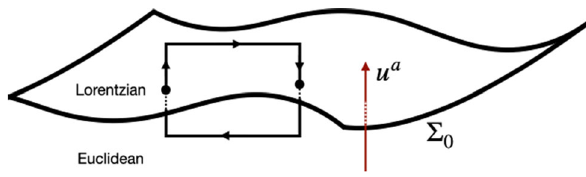
Fig. 1 Loops straddling the transition surface (cid:2)